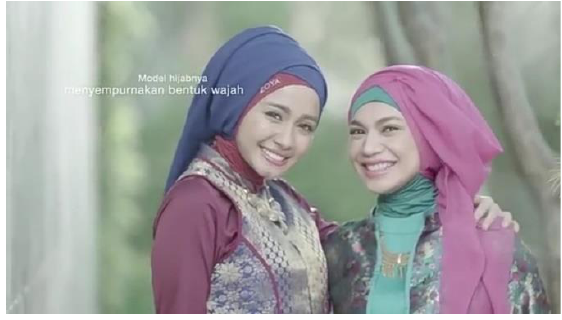
Figure 11: Confident Muslim